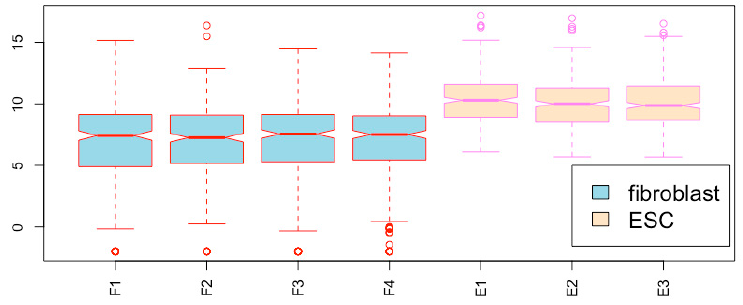
Figure 20. Define the orientation of axis labels, and add a legend to the figure.